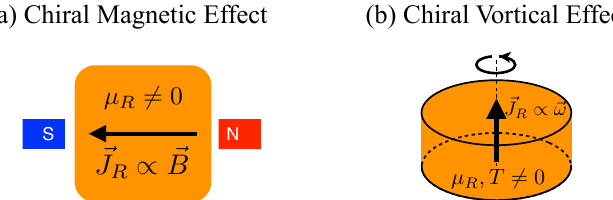
Figure 1. The schematic picture of the anomaly-induced transport phenomena: ( a ) Chiral magnetic effect. ( b ) Chiral vortical